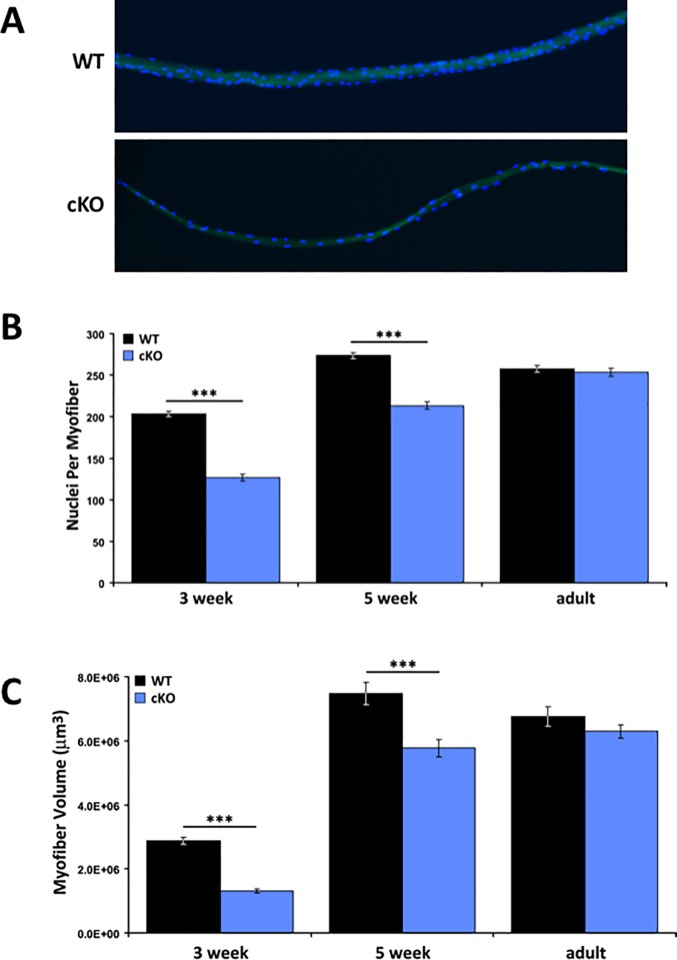
Myofibers from Atrx cKO mice are smaller and contain fewer nuclei.(A) DAPI stained nuclei on representative fibers isolated from 3-week old WT and Atrx cKO EDL muscle. The green is autofluorescence, used to visualize the fibers. (B) Average myonuclear content per fiber in EDL muscle in Atrx cKO and littermate controls (mean ± SEM; ***p<0.001 by student’s t-test; 3 week WT, cKO: n = 110, 119 fibers; 5 week WT, cKO: n = 160, 149 fibers; adult WT, cKO: n = 183, 212 fibers). (C) Average volume per fiber in EDL muscle in Atrx cKO and littermate controls. (mean ± SEM; ***p<0.001 by student’s t-test; 3 week WT, cKO: n = 111, 122 fibers; 5 week WT, cKO: n = 170, 178 fibers; adult WT, cKO: n = 186, 214 fibers). Fibers were collected from 2 mice/group at 3 weeks; 3 mice/group at 5 weeks and adult ages.